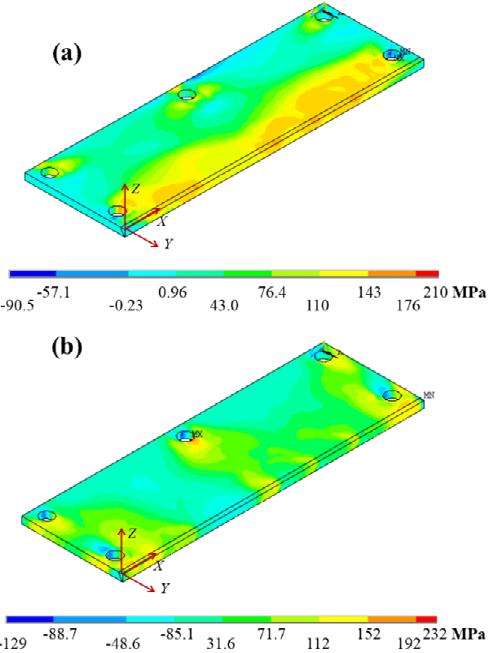
Figure 15. Residual stresses generated on the welded plates restricted by bolts: ( a ) X-direction and ( b ) Y-direction.